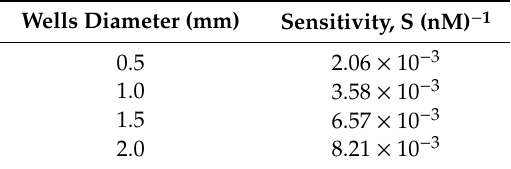
Table 2. Summary of third structure memristor sensor sensitivity for four wells